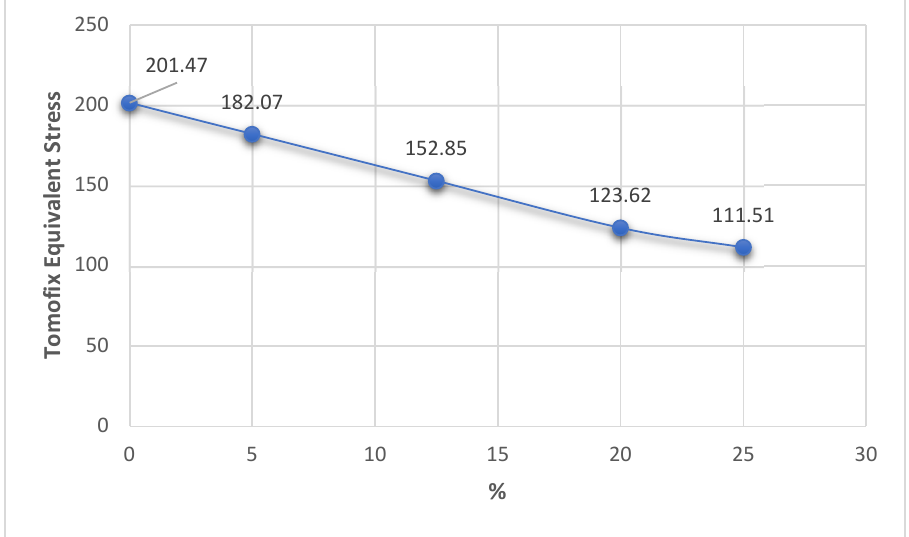
Figure 18. Variation in the TomoFix equivalent stress related to the overcorrection positions.